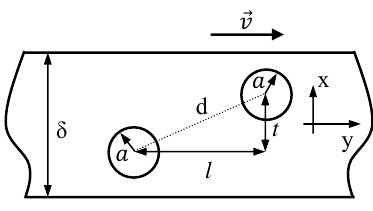
Figure 7: Plan view of the conducting strip of width δ mov- ing along y with the two poles with centers separated by a distance d